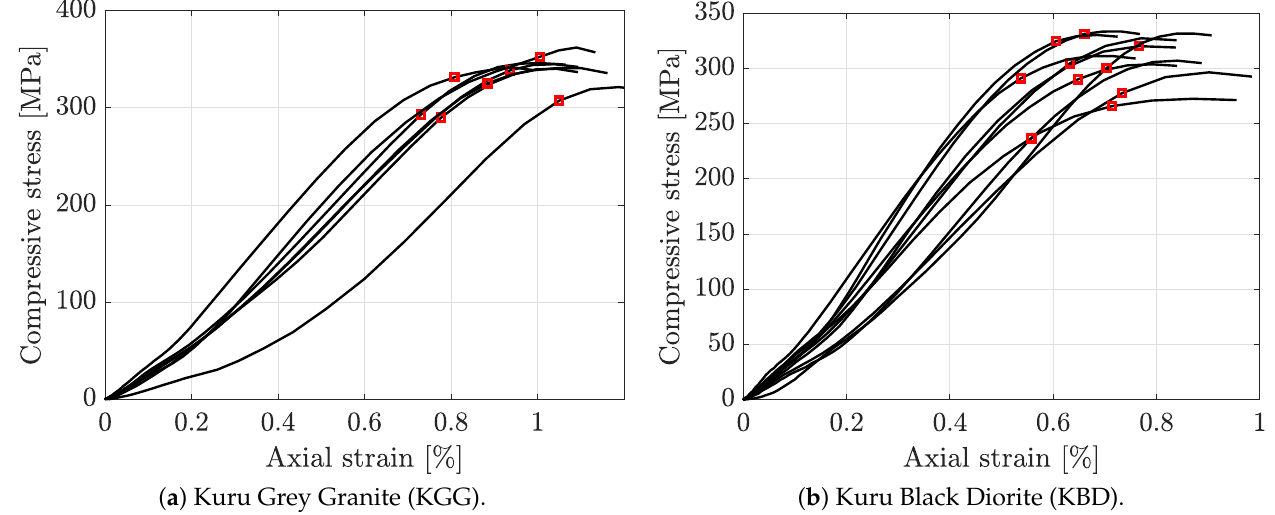
Figure 12. Dynamic compressive stress versus axial strain for the investigated rocks. The red star marks the instant at which crack initiation could be observed in the high-speed images. Table 6. Summary of quasi-static and dynamic uniaxial compression